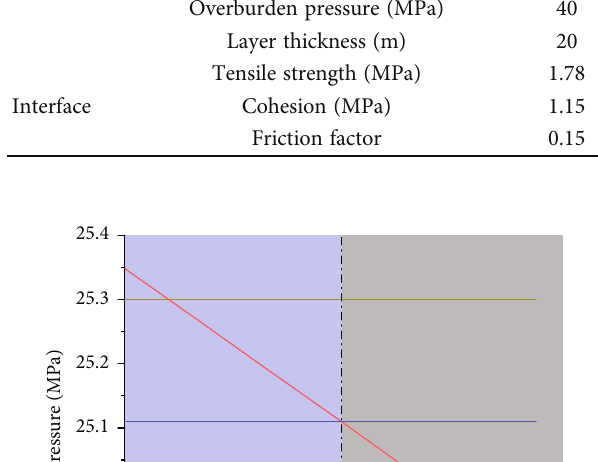
Figure 4: Changes in P di ff